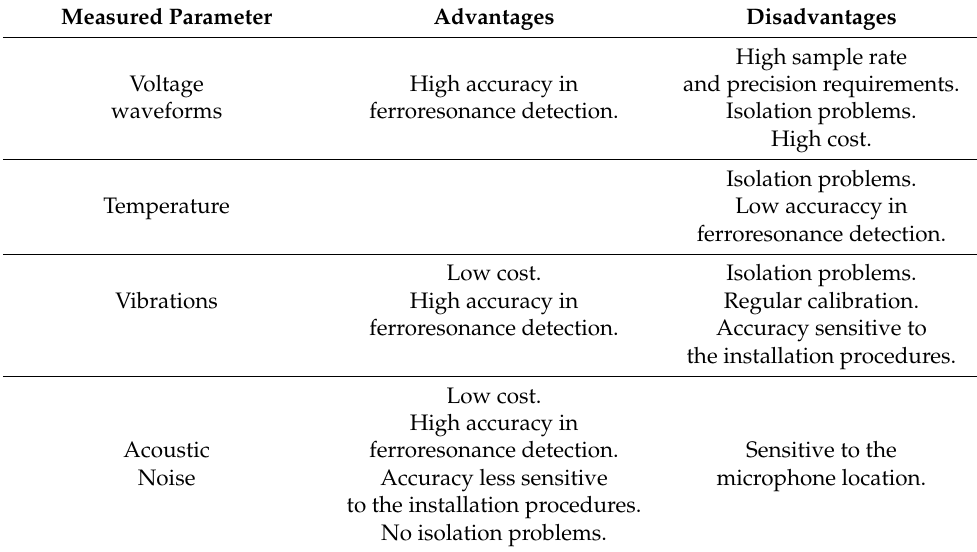
Table 6. Advantages and disadvantages of existing ferroresonance-detection